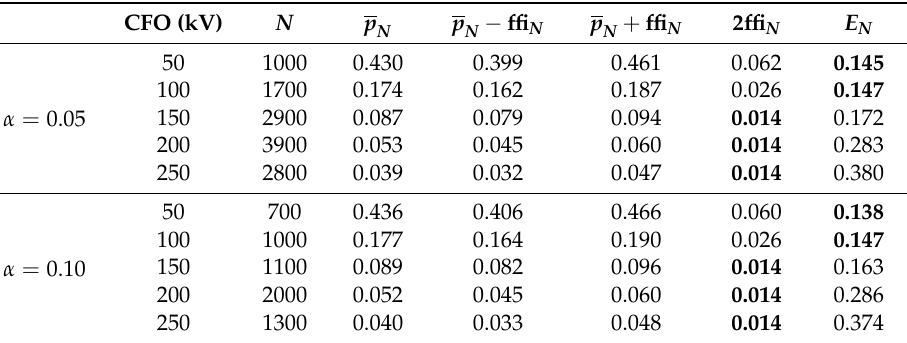
Table 4. Stopping criterion results for Test3.